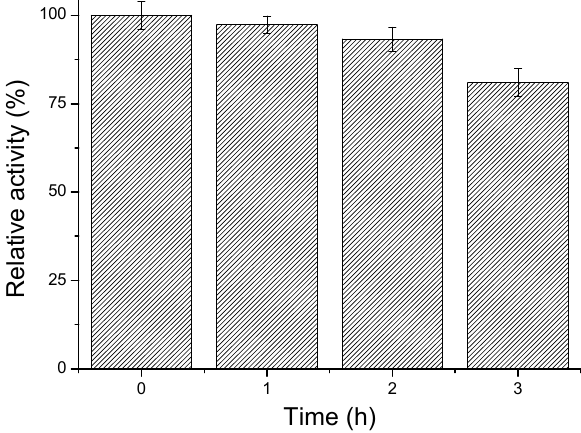
Figure 2. ( A ) Effect of glutaraldehyde concentration on the global activity recovery of CGTase CLEAs (enzyme solution prepared in 50 mM sodium citrate buffer pH 6.0, precipitation with acetone at a volumetric concentration of 75%, 1 h precipitation at 20 °C followed by 3 h crosslinking with glutaraldehyde under 200 rpm stirring); ( B ) influence of crosslinking time with 20 mM glutaraldehyde on the global activity recovery (precipitation and crosslinking conditions at the same conditions above).